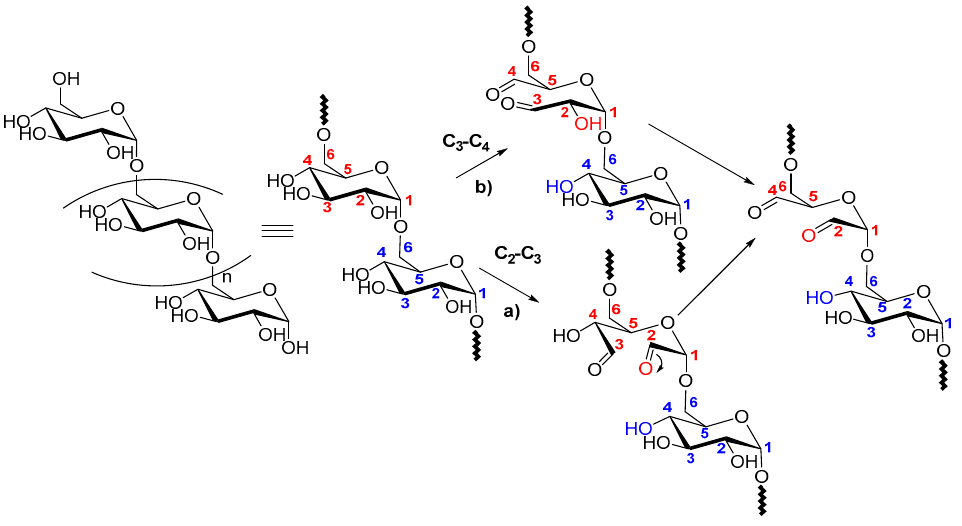
Figure 4. Possible structures of oxidized dextran (dexOx).